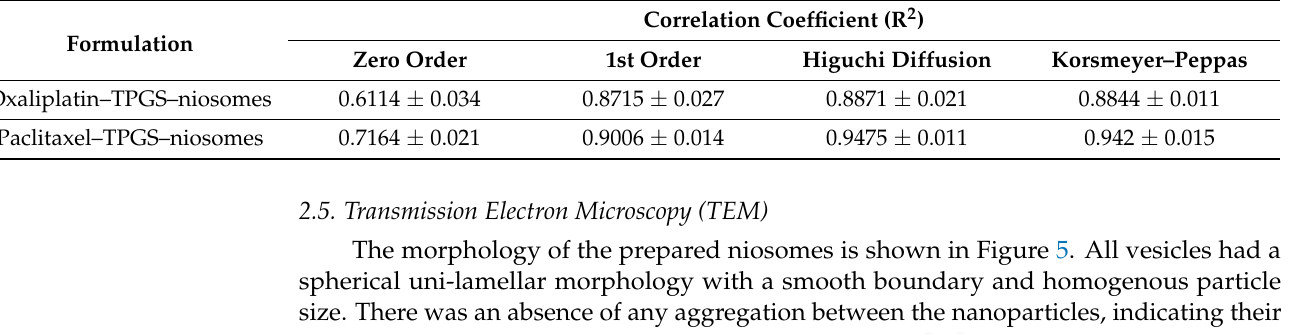
Figure 4. In vitro cumulative drug release profile from Oxaliplatin–TPGS niosomes, Paclitaxel– TPGS niosomes, Oxaliplatin free drug and Paclitaxel free drug. Table 4. Different mathematical models of in vitro release data (means ± SD, n = 3).